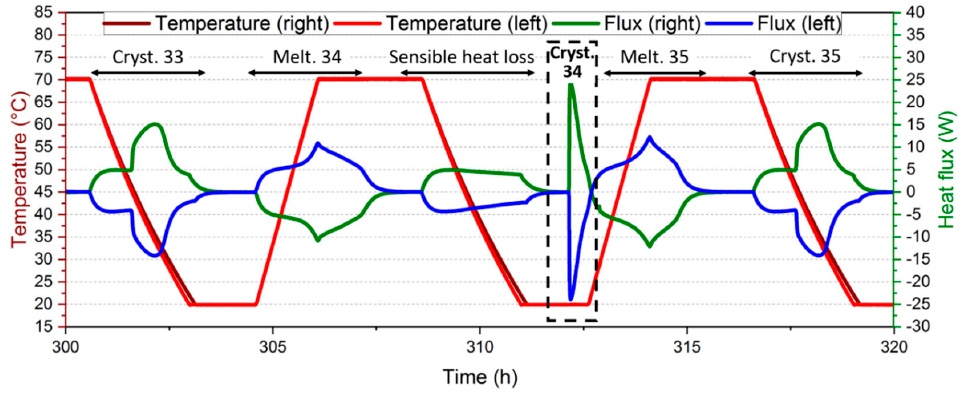
Figure 9. Singular crystallization at 20 °C for the 34th cycle of the experiment. Cryst.: crystallization. Melt.: melting. During this 34th crystallization, the heat flux was not stabilized and the core of the